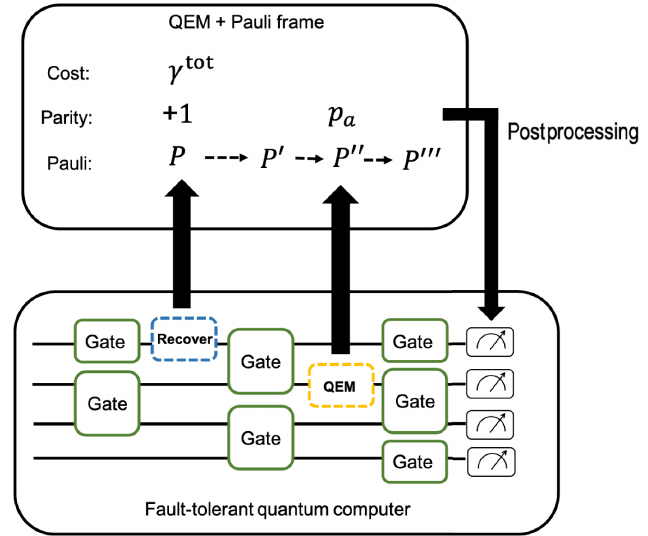
FIG. 3. Schematic figure for the Pauli frame incorporating QEM. If a QEM recovery operation is a Pauli operation, it is not directly applied to the quantum computer but rather the Pauli frame is updated instead. The parity is also updated in accordance with the generated recovery operations of QEM. Here, we denote the parity corresponding to the QEM recovery operation as p a in the figure. If a QEM recovery operation is not a Pauli operator, it is performed physically. Then measurement outcomes are then postprocessed depending on the Pauli frame, parity, and QEM